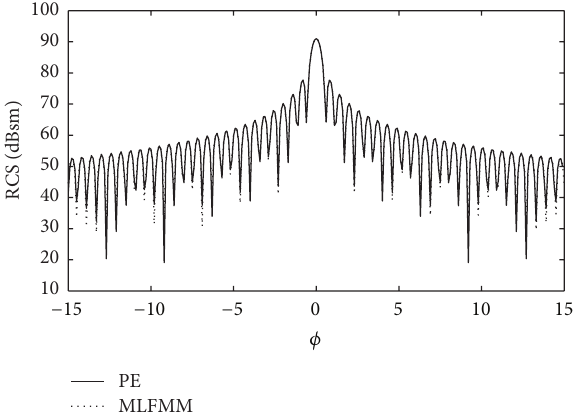
Figure 6: RCS of PEC square calculated by PE and